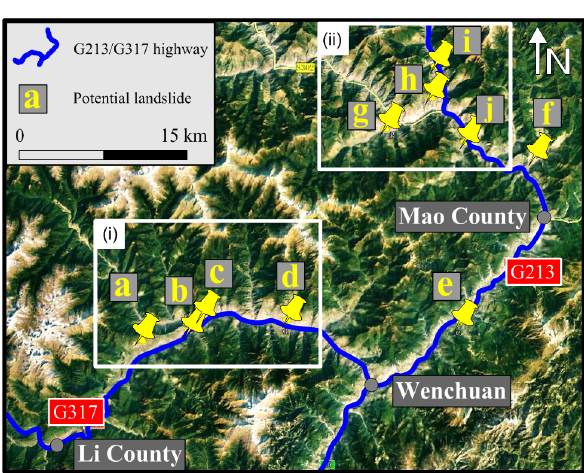
Figure 3. landslide early detection map derived from QM DInSAR method